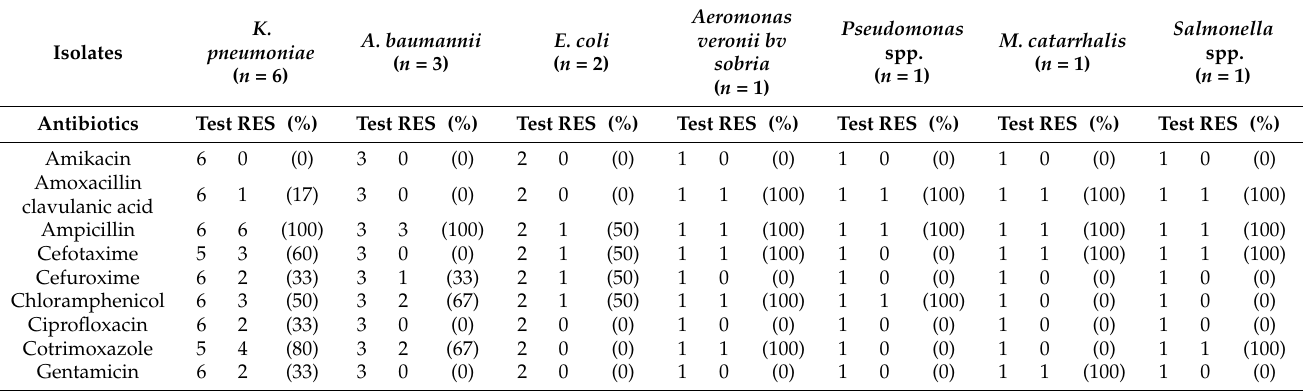
Table 4. Antibiotic susceptibility testing patterns of Gram-negative isolates ( n = 15) among neonates with culture-confirmed sepsis at the 37 Military Hospital, Accra, Ghana